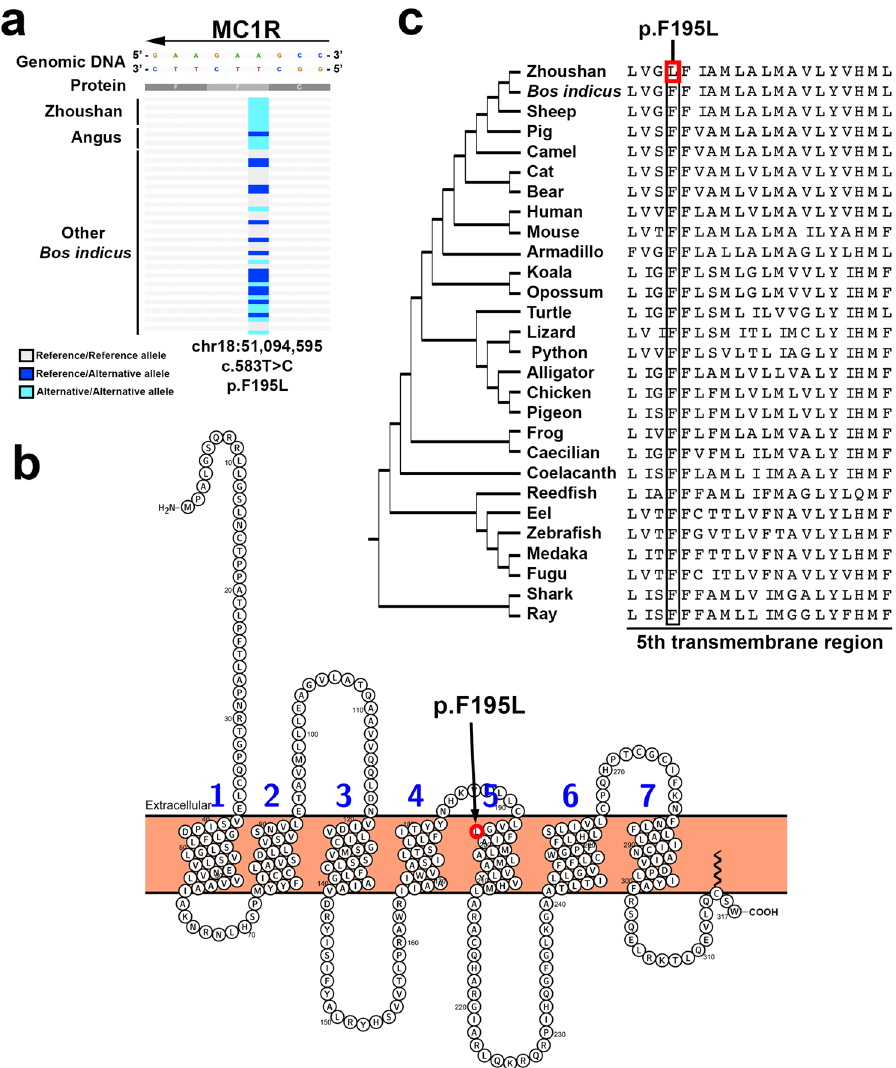
Figure 4. Secondary structure of MC1R and protein sequence alignment of MC1R orthologs. ( a ) Regional highlight of the c.583 T > C mutation of MC1R. The genomic region from 51,094,590 to 51,094,598 bp on chromosome 18 is shown. Note that MC1R is located on the reverse strand. ( b ) Secondary structure of MC1R. MC1R is a seven-transmembrane receptor. The p.F195L mutation is located in the 5th transmembrane region and enclosed by the red circle. This figure is generated by using the Protter server application 39 . ( c ) Multiple sequence alignment of MC1R orthologs. The black rectangle highlights the 195th phenylalanine residues. The red rectangle encloses the p.F195L mutation in Zhoushan cattle. The cladogram of the species is shown to the left of the species name. The cladogram topology is derived from a previous study 40